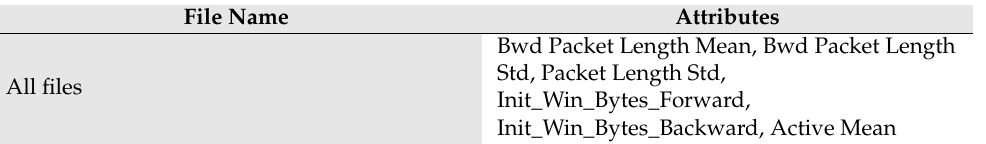
Table 6. Attributes selected in the complete dataset (binary